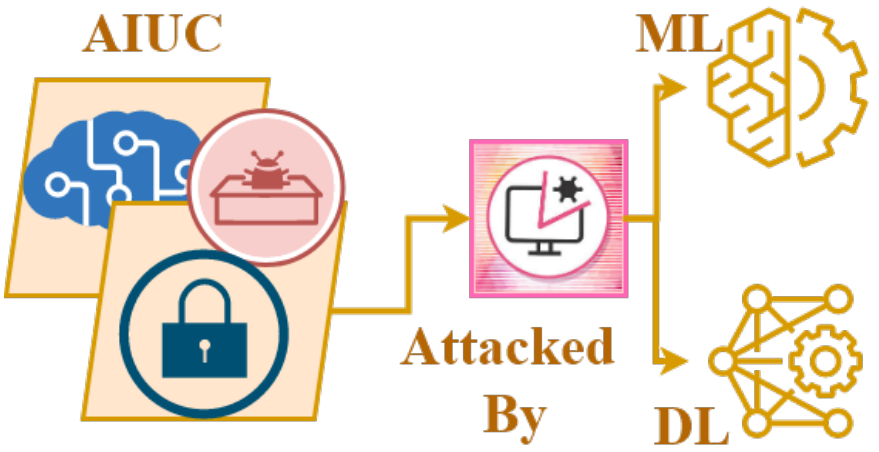
Figure 3. AIUC: Vulnerable to ML and DL